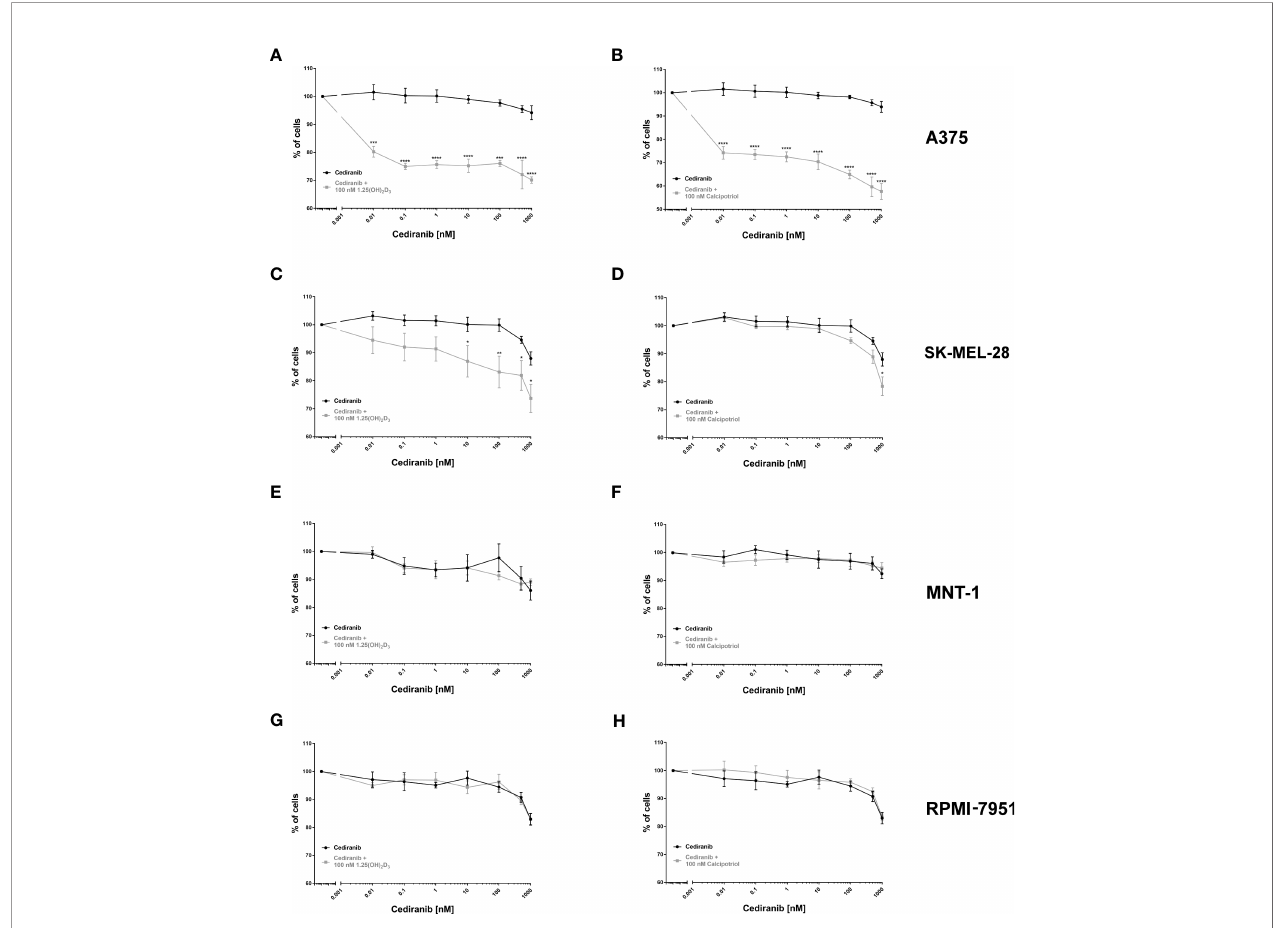
FIGURE 1 | The effect of cediranib or its combination with vitamin D analogs [left column — 1,25(OH) 2 D 3 ; right column — calcipotriol] on the proliferation of human malignant melanoma A375, MNT-1, RPMI-7951, and SK-MEL-28 cells [ (A, B) — A375; (C, D) — SK-MEL-28; (E, F) — MNT-1 and (G, H) — RPMI-7951 cell lines]. The cells were treated with serial dilutions (0.01 – 1,000 nM) of cediranib alone or in combination either with 1,25(OH) 2 D 3 or with calcipotriol for 72 h. The same cediranib data are plotted in each graph from the same melanoma cell line, except for MNT-1 cells. Data are shown as mean from three or four independent experiments ( n = 4 – 6 in each) ± SEM. Statistical signi fi cance between plots (between relevant concentrations of cediranib alone or with vitamin D) was estimated using two – way ANOVA and presented as * p < 0.05; ** p < 0.01, *** p < 0.001, or **** p <